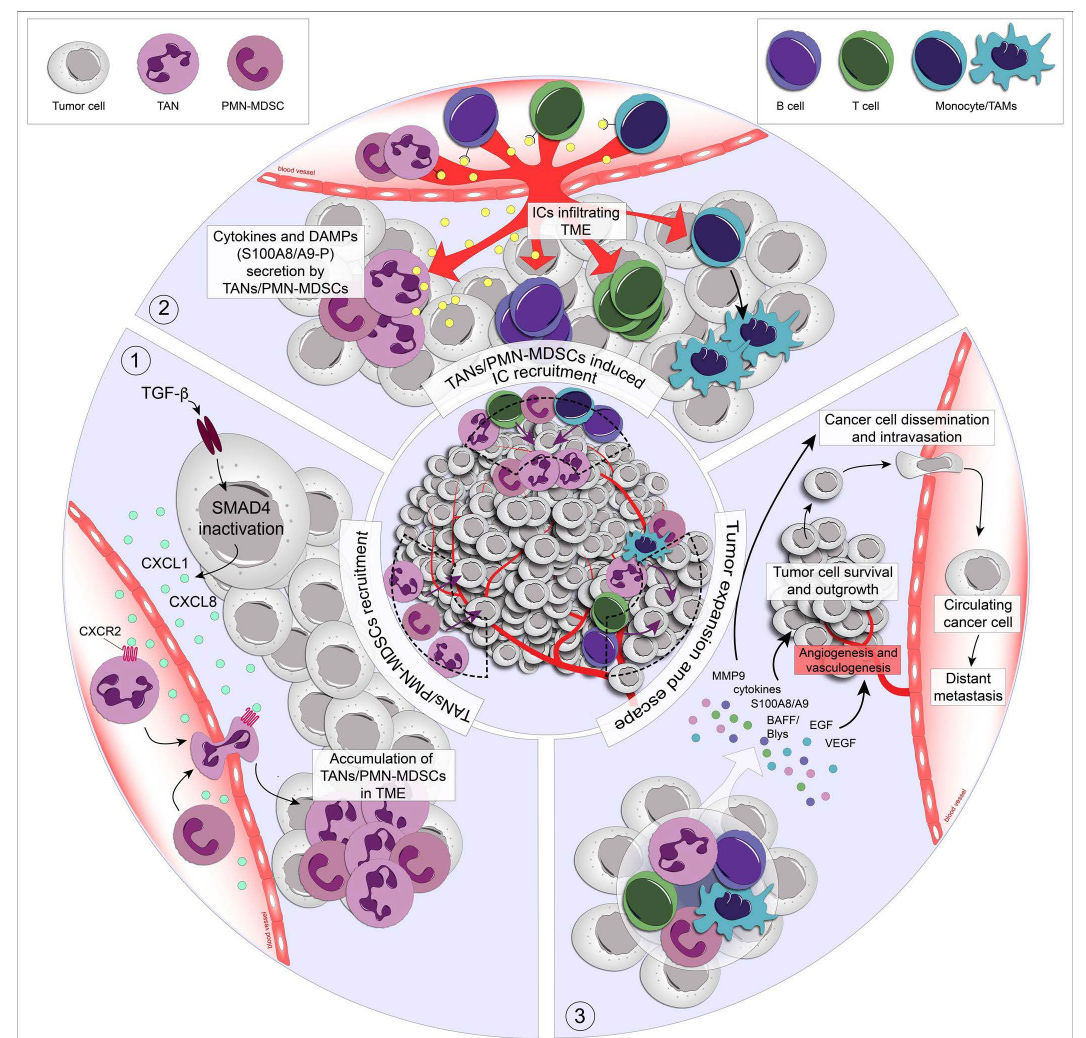
Figure 1. TAN recruitment promotes tumor growth and propagation. The interaction between TANs/PMN-MDSCs, tumor, and immune cells (ICs) is illustrated in the center. The details of various processes are highlighted at the periphery: (1) Recruitment of TANs/PMN-MDSCs to the tumor microenvironment (TME); TGF- β induces the inactivation of SMAD4 in cancer cells and the secretion of CXCL1 and CXCL8. These chemokines attract the circulating neutrophils to the TME via CXCR2. (2) Immune cell (IC) recruitment; once in the TME, neutrophils begin to secrete cytokines and DAMPs, which induce an adapted immune response and lead to IC recruitment. (3) Tumor cell growth and dissemination; TANs/PMN-MDSCs and recruited ICs secrete a plethora of mediators, which promote angiogenesis, tumor cell survival, and growth as well as